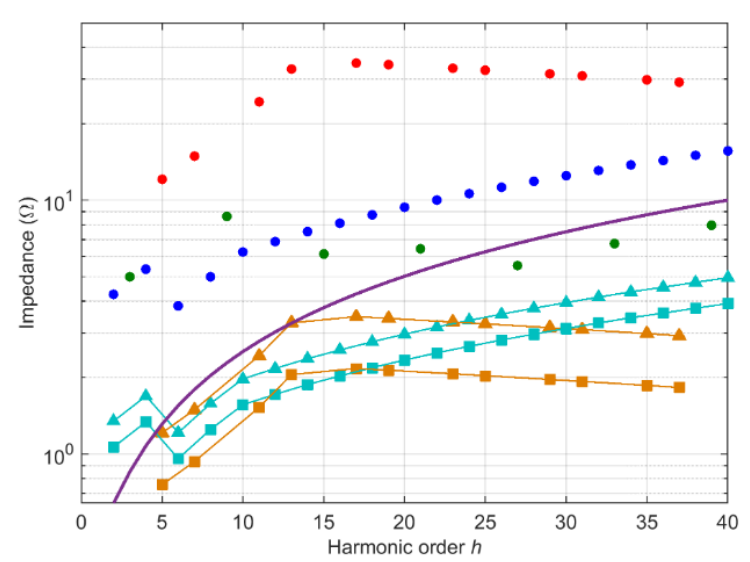
Figure 8. Harmonic impedance for selected groups: odd harmonics multiple of 3 ( green dots ), even harmonics ( blue dots ) and odd characteristic harmonics ( red dots ); recalculated network impedance ˆ Z (cid:48) for even ( ˆ Z (cid:48) ˆ Z (cid:48) e , light blue ) and odd characteristic ( oc , light brown ) harmonics (triangles are for the n = 10 case, squares for n = 15). The violet curve is the linear extrapolation with harmonic order of the reference impedance of the IEC